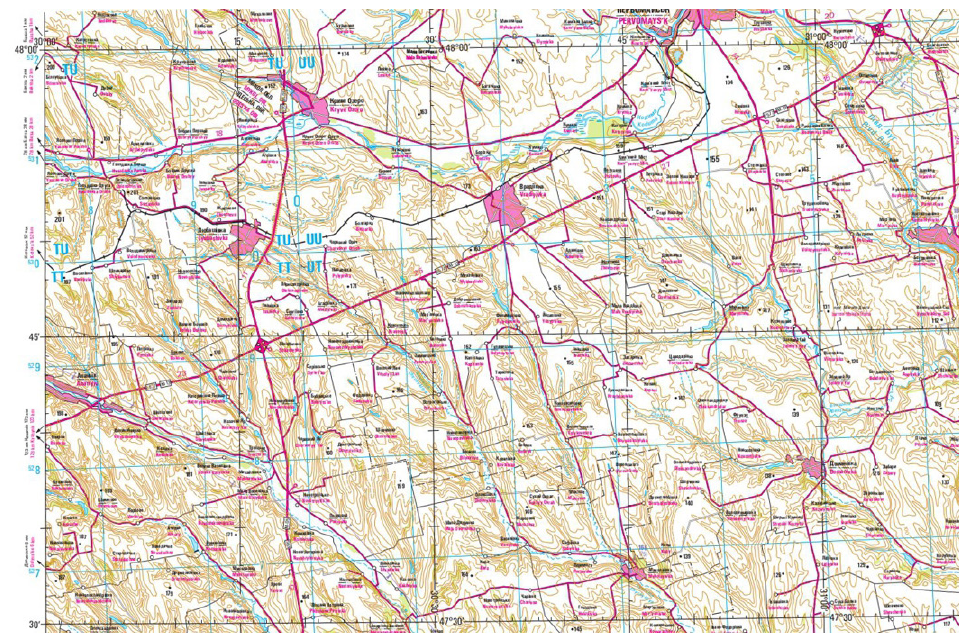
Fig. 4. A part of the 1:250,000 scale topographic map